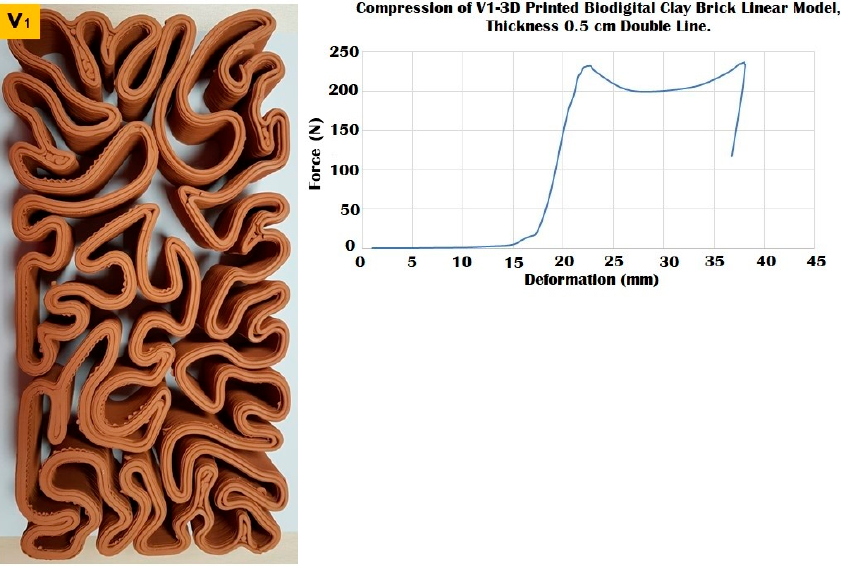
Figure 9. Exhibits the linear brick model of the V1 family of the biodigital clay bricks with double line linear thickness of 0.5 cm in the physical 3D-printed model ( left ). The graph exhibits the results of the compression test for the V1 linear model brick, showing the relation between force (N) ( Y -axis) and deformation (mm) ( X -axis). This model exhibited maximum durability by resisting until 240 N before it started cracking and maintaining its resistance from 25 to 35 mm deformation under 200–250 N before collapsing at 240 N. While the V2 linear brick model with a surface area of 15,980.9 mm 2 recorded the